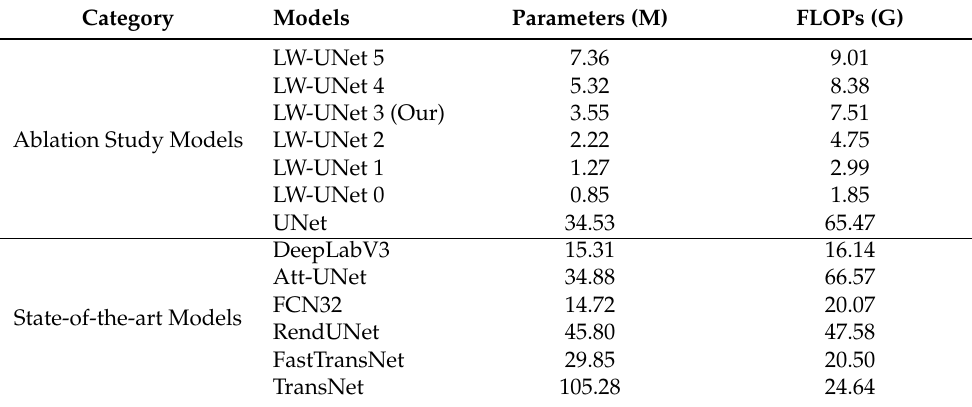
Table 4. Comparison Parameters and FLOPs with Other